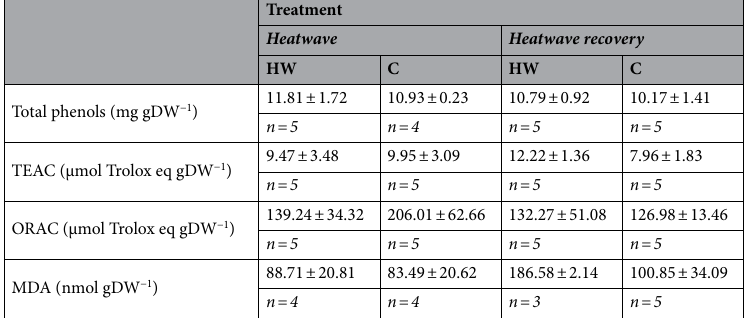
Table 2. Total phenols (mg gDW −1 ), TEAC (μmol Trolox eq gDW −1 ), ORAC (μmol Trolox eq gDW −1 ) and MDA (nmol gDW −1 ) concentrations in mature C. nodosa ’s leaves from heatwave (HW) and control (C) tanks, during the heatwave and after recovery. Values are means ± SE and n is the number of replicates.